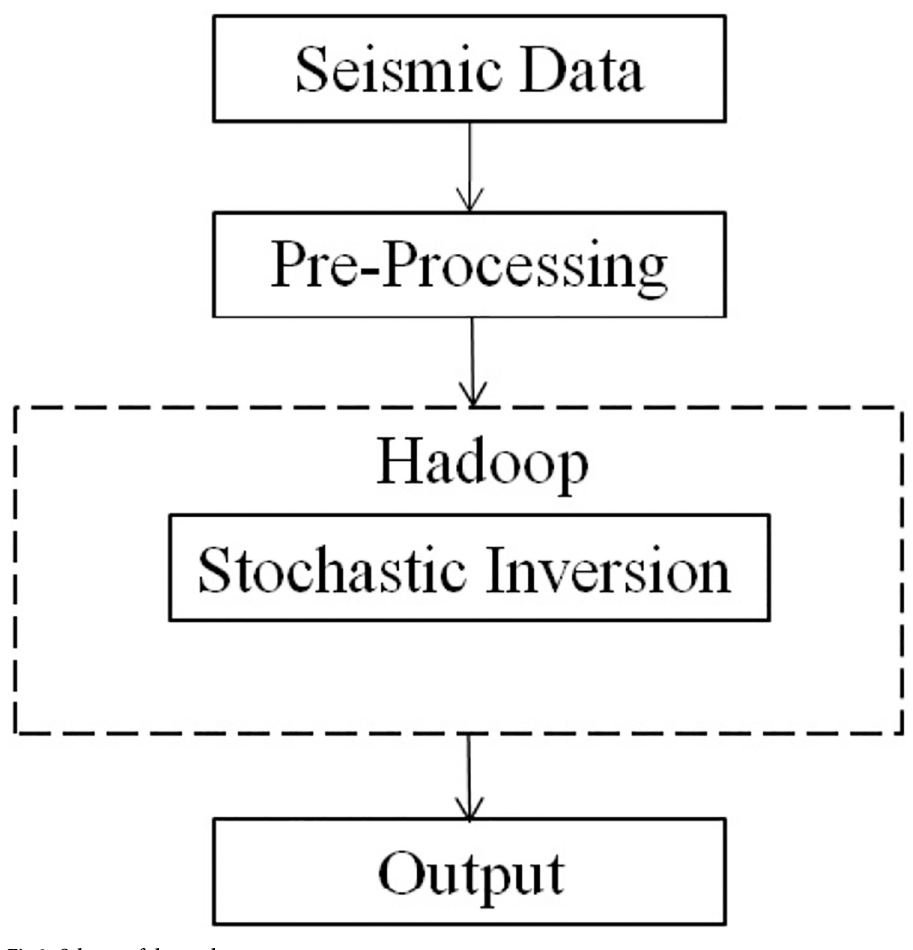
Fig 2. Schema of the work.